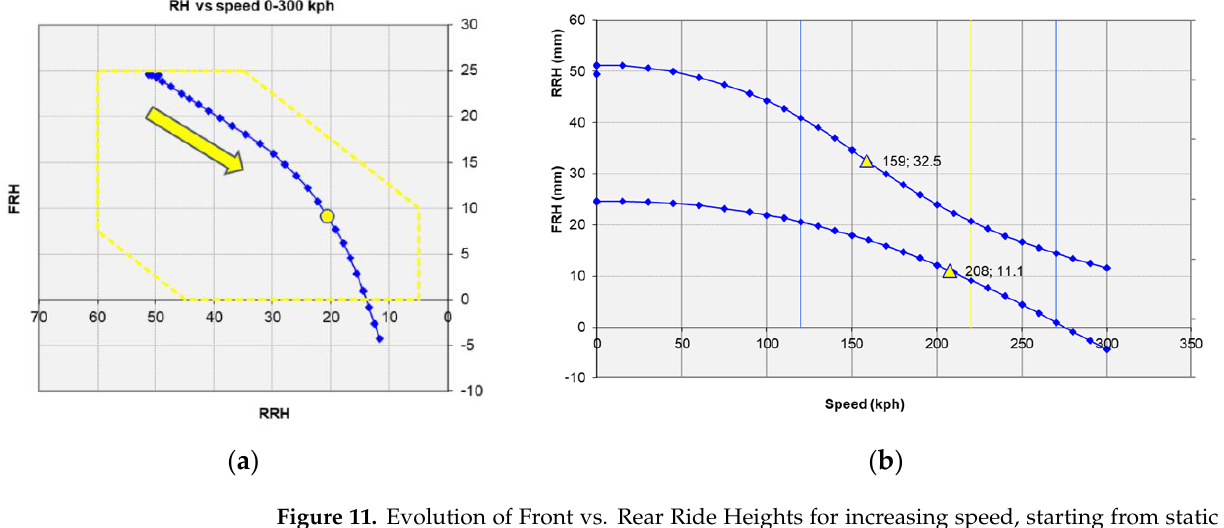
Figure 11. Evolution of Front vs. Rear Ride Heights for increasing speed, starting from static RH values: ( a ) speed increases along yellow arrow and the area inside the yellow dotted line is the aero map domain; ( b ) this is the most significant graph for trackside engineering activities. Vertical red and yellow lines are references for the relevant speed range on a given circuit; yellow markers show where bump stops come into play.